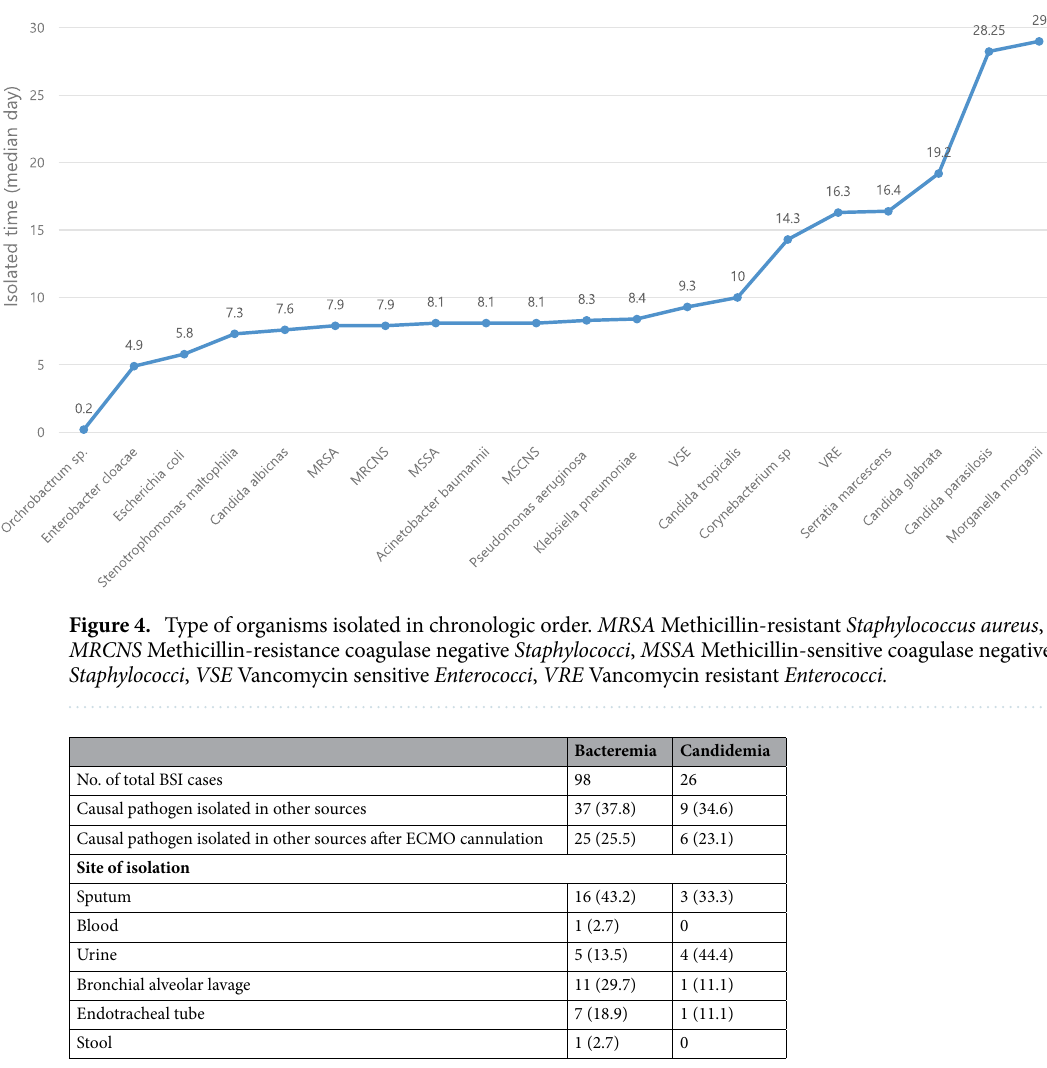
Table 4. Causal pathogen isolated in other sources before bacteremia or candidemia. Data are expressed as number (percent). BSI bloodstream infection, ECMO extracorporeal membrane oxygenation.